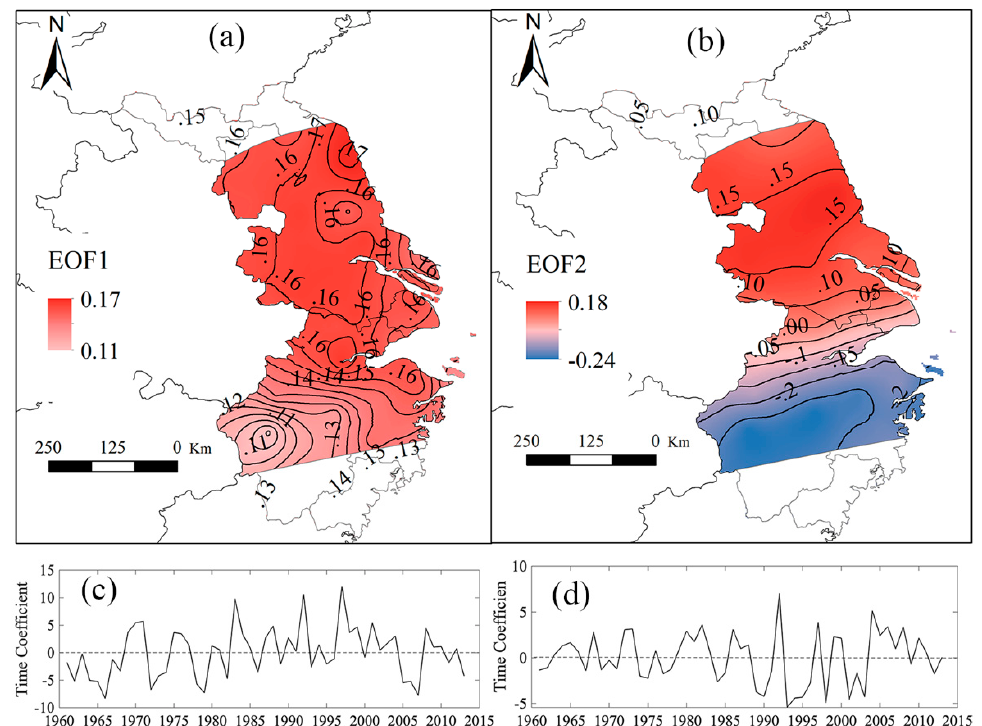
Figure 6. The spatial patterns of the two leading EOF modes of plum rainfall: ( a ) EOF 1, ( b ) EOF 2, and the corresponding ( c , d ) normalized temporal coefficients.